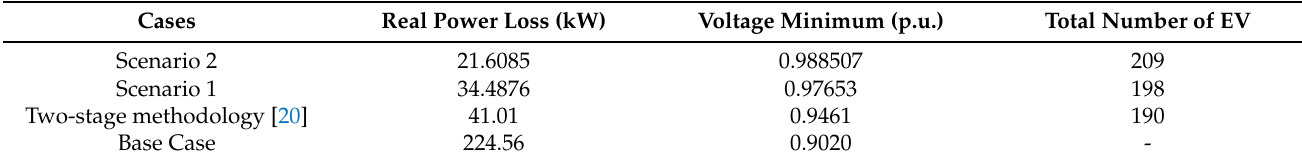
Table 11. Comparison results.